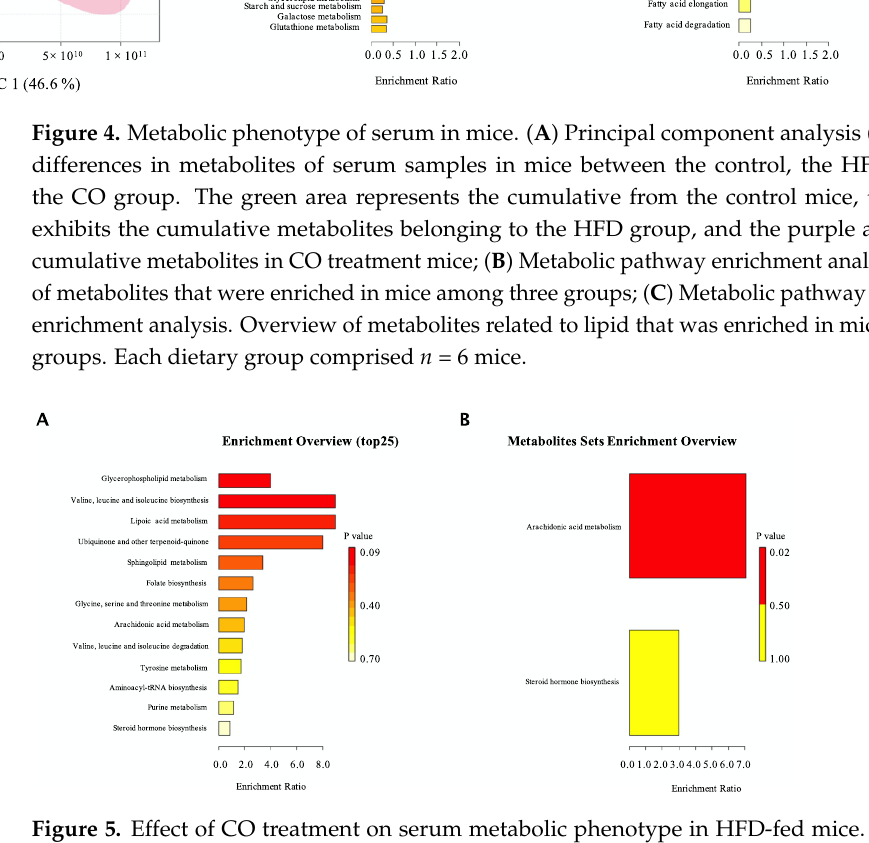
Figure 5. Effect of CO treatment on serum metabolic phenotype in HFD-fed mice. ( A ) Metabolic pathway enrichment analysis. Overview of metabolites that were enriched in mice treated with CO fed a high-fat diet compared to the HFD group; ( B ) Metabolic pathway related to lipid enrichment analysis. Overview of metabolites related to lipid that was enriched in mice treated with CO fed a high-fat diet compared to the HFD group. Each dietary group comprised n = 6 mice.